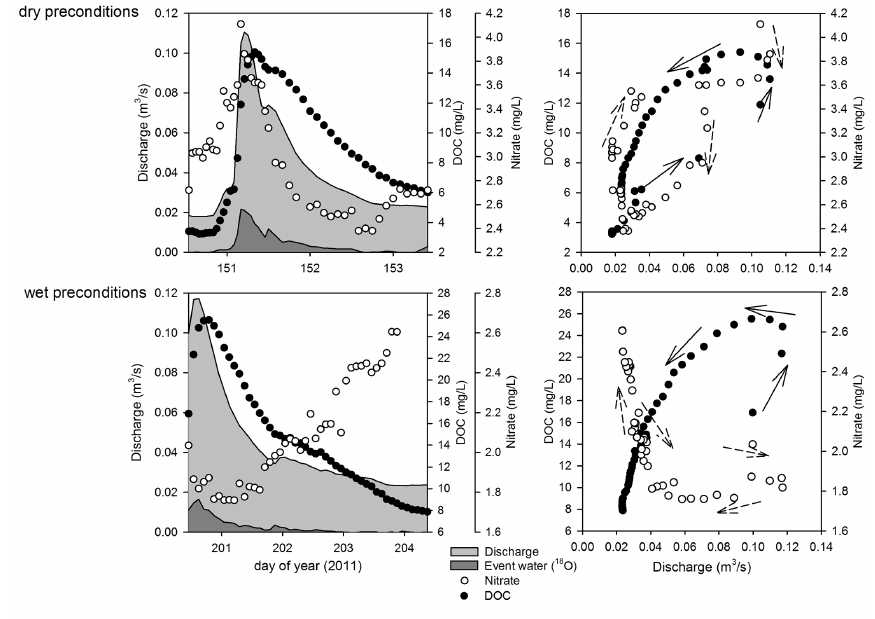
Fig. 3. Hydrographs (light gray) and concentrations of DOC and nitrate for the two selected discharge events under dry antecedent conditions (groundwater table 62cm below surface at reference well, 31 May 2011, 41mm of rainfall) and wet preconditions (groundwater table 19cm below surface at reference well, 20 July 2011, 23mm of rainfall). Contributions of event water as estimated from a two component mixing model of δ 18 O from rainwater and pre-event base flow are depicted in dark gray. Note that the initial nitrate peak under dry preconditions coincided with the maximum in event water distribution, while under wet preconditions there was no nitrate flushing and the concentration minimum coincided with the DOC maximum. Furthermore, under dry preconditions concentrations of DOC remained lower, despite a comparable contribution of event water. Corresponding graphs on the right represent the same events as concentration vs. discharge plots (C- Q-plots) to identify the discharge patterns of the respective source terms (Evans and Davies, 1998). Dashed arrows mark the C–Q hysteresis of nitrate (open circles), solid arrows indicate the pattern for DOC (solid dots). Table 2. Correlations (Pearson) in surface water between discharge, solutes and groundwater level (GW, in m below surface). Data for Q, DOC, nitrate, sulfate and iron: this study; data for pH from Knorr (2010)